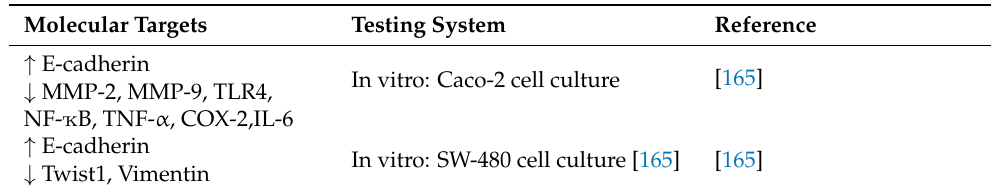
Table 8. Reported targets of quercetin active in suppression of migration and invasion of CRC models alongside their in vitro testing system. “ ↑ ” and “ ↓ ” arrows are indicating the up- and downregulation, respectively.